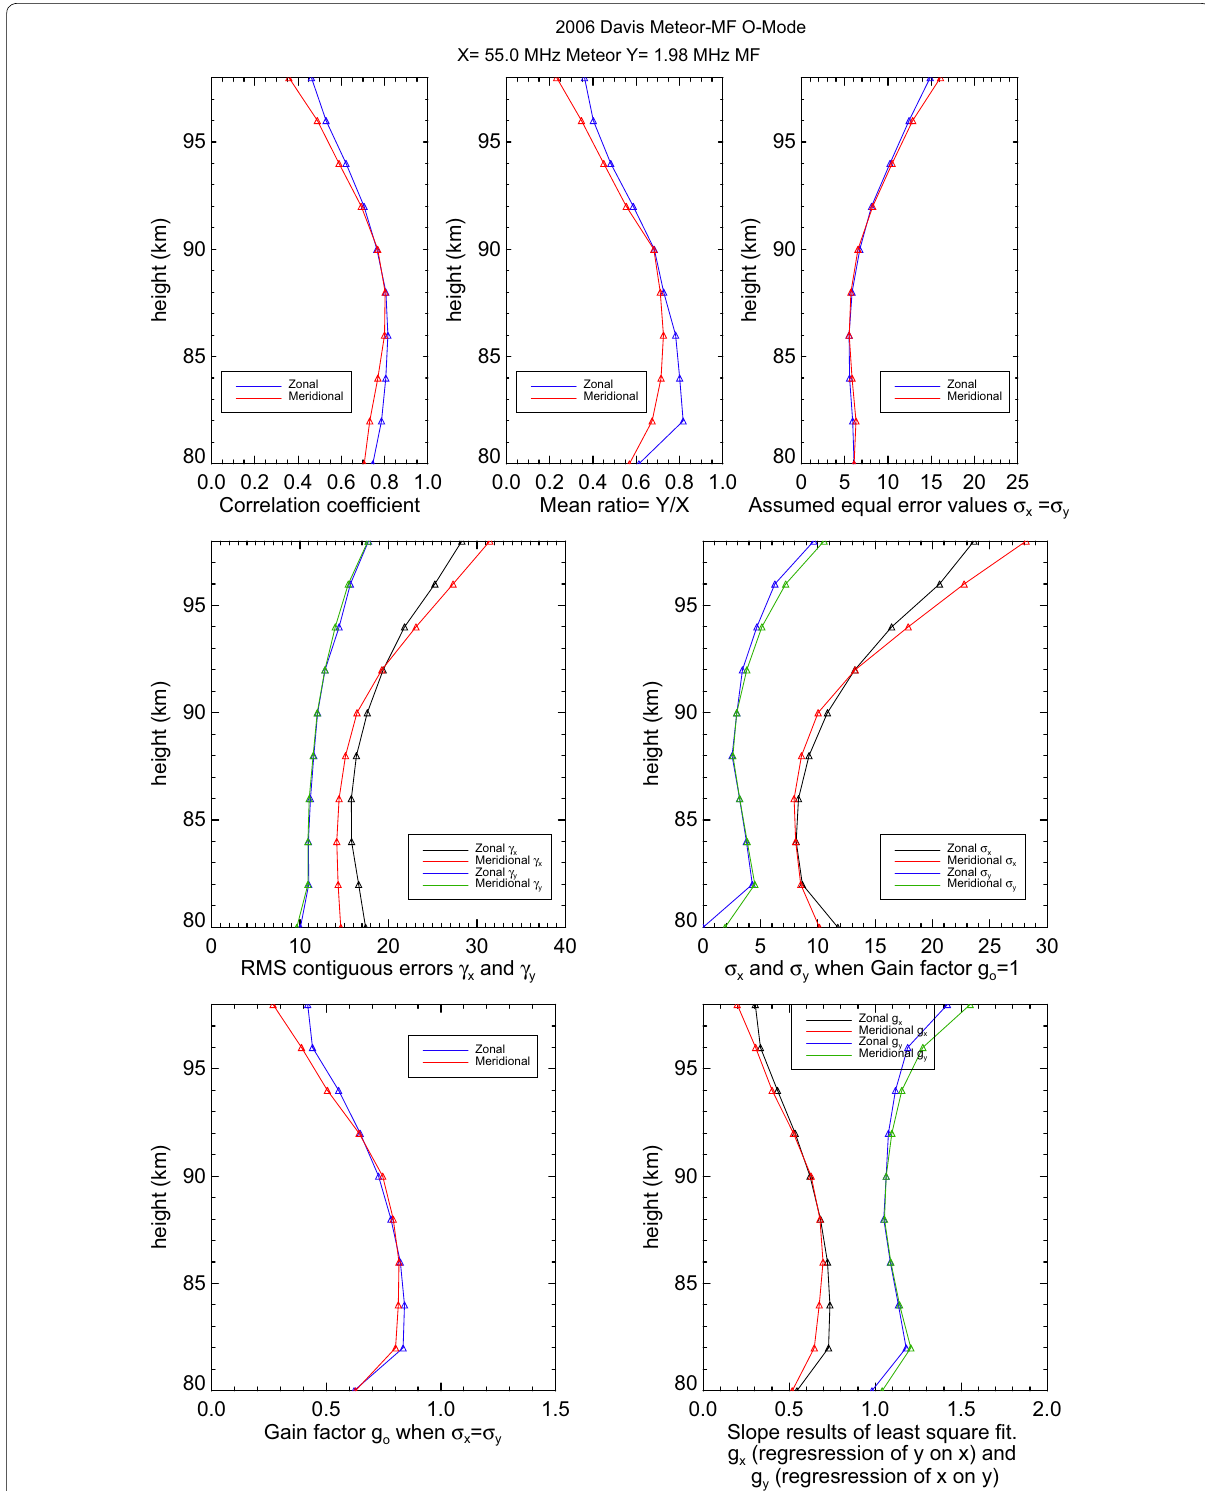
Fig. 7 Davis MF O-mode and 55 MHz meteor scatter plot comparison results. The plots above summarize the results from applying the regression analysis to the data at all heights. In the fourth, fifth, and last panels, red and black indicate the 55 MHz radar and green and blue the 1.94 MHz radar results. Note that the results at 80 km are of a somewhat different